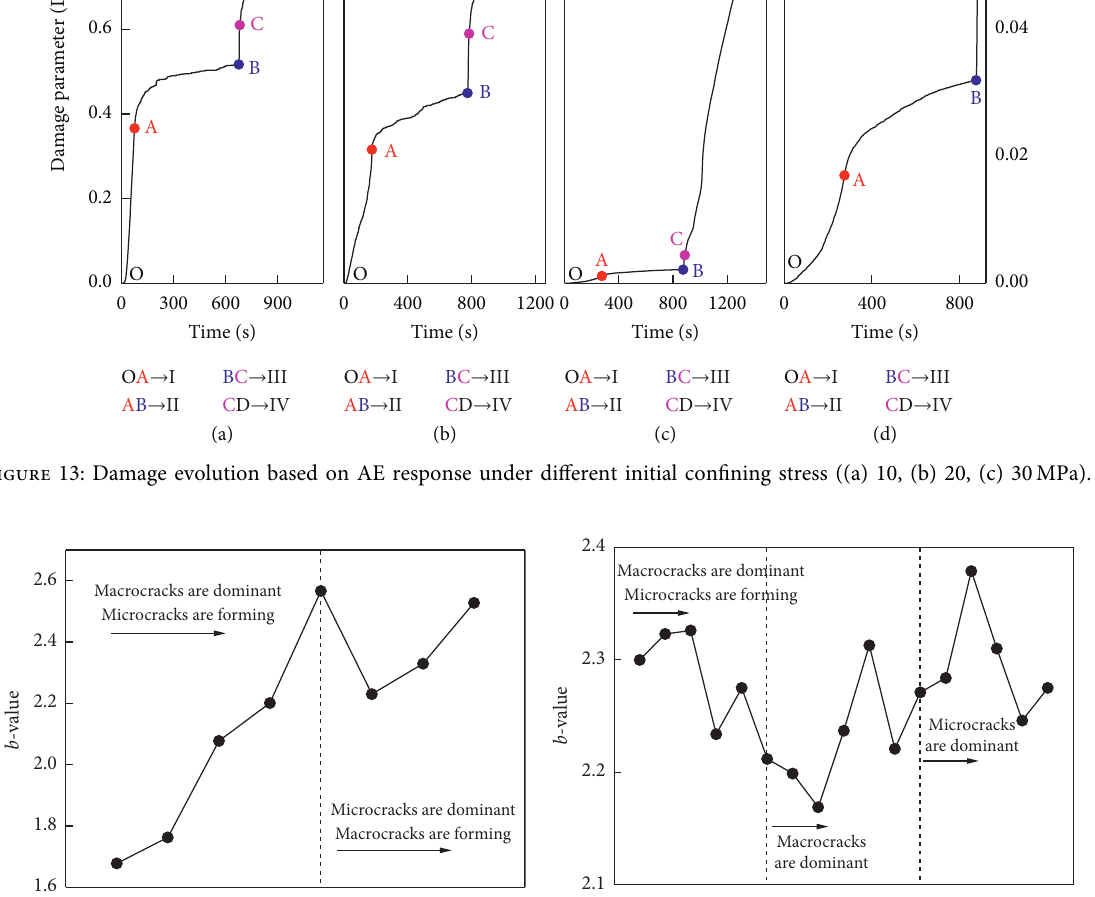
Figure 14: Variation of b -value in the process of failure under confining stress of 30MPa: (a) unloading stage and (b) maintaining stage after